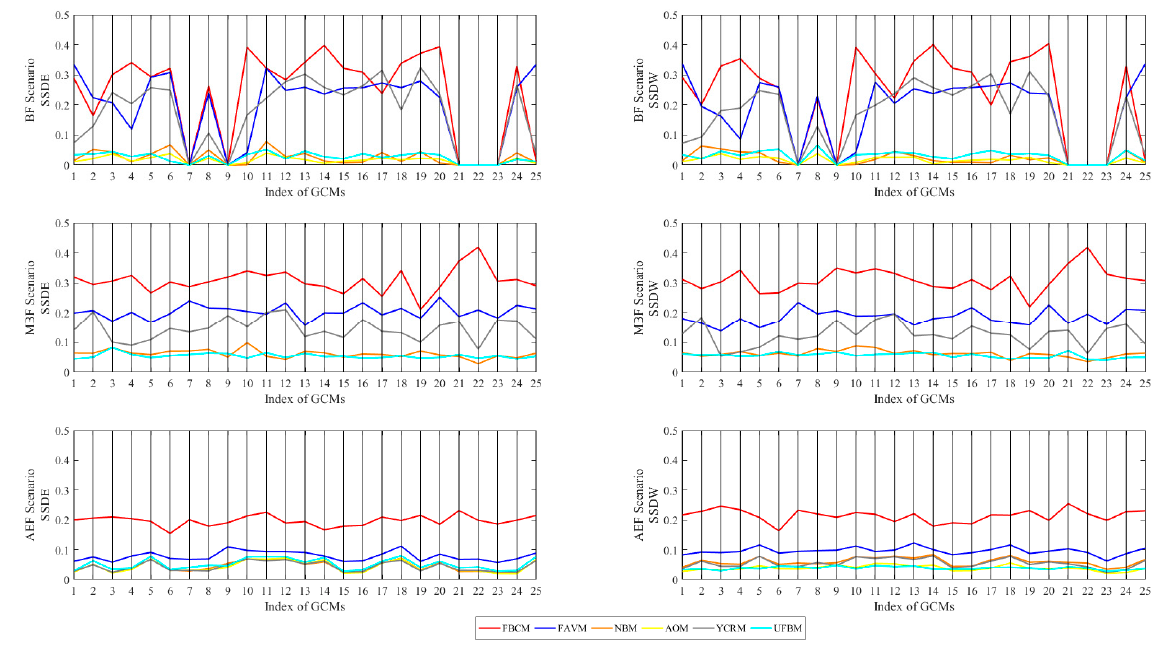
Figure 8. SSDE and SSDW obtained by six conflict-resolution methods under different GCMs and EF patterns (FBCM: fuzzy Borda counting method; FAVM: fuzzy approval voting method; NBM: Nash bargaining method; AOM: alternating offer method; YCRM: Young conflict-resolution method; UFBM: unanimity fallback bargaining method; BF: basic flow; MBF: maintenance basic flow; AEF: appropriate environmental flow; SSDE: standard deviation of hydropower stakeholder’ satisfied degree value; SSDW: standard deviation of environmental stakeholder’ satisfied degree value).